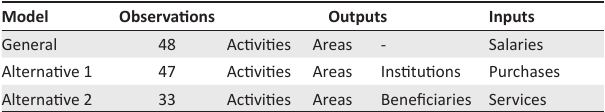
TABLE 4: Models employed to perform data envelopment